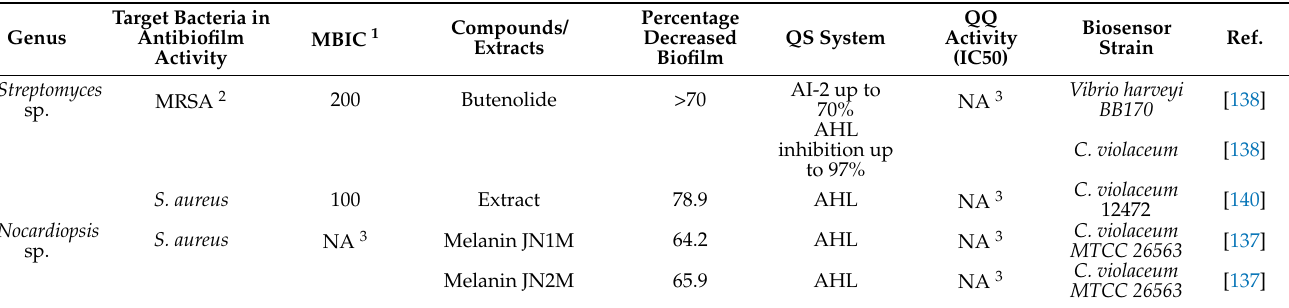
Table 4. Anti-biofilm, antibacterial, and quorum-quenching activity of crude extracts or compounds from marine